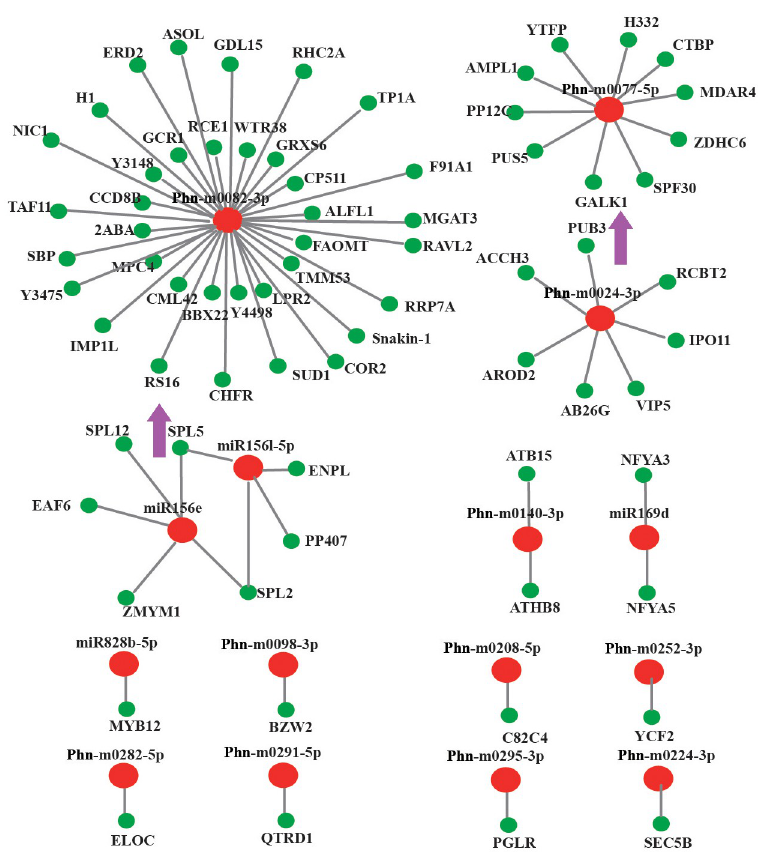
Fig 8. Stem-special miRNAs and their target genes. A combined view of stem-special miRNAs and their targets. Pink tip represents significant negative correlation.